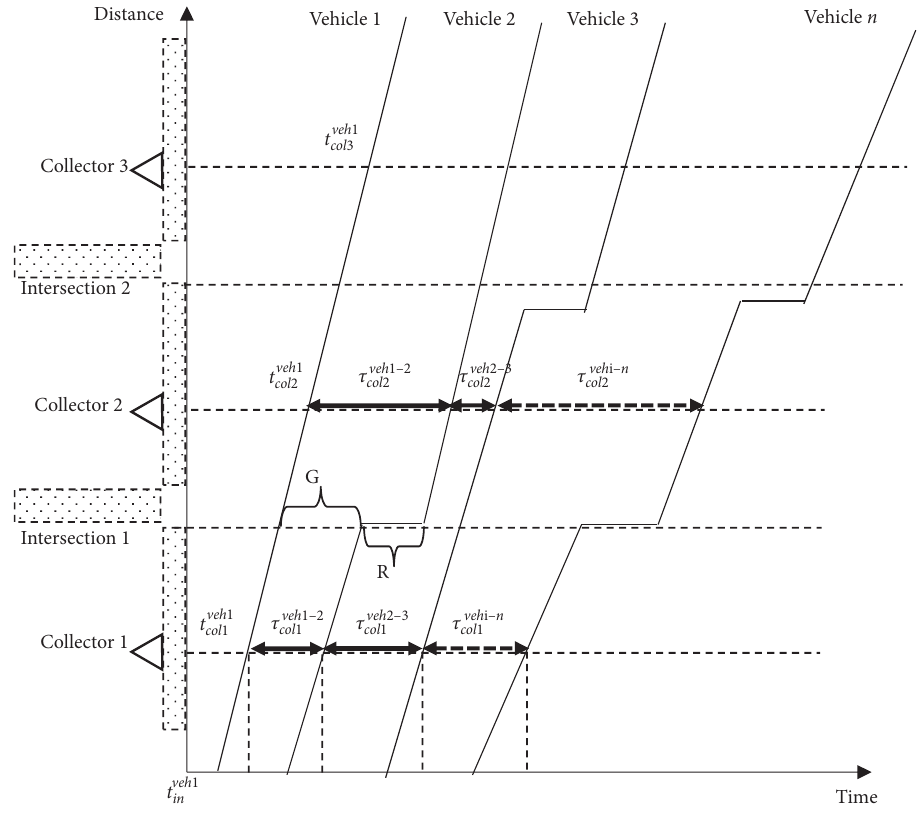
Figure 1: Vehicle travel time running through multi-intersections and